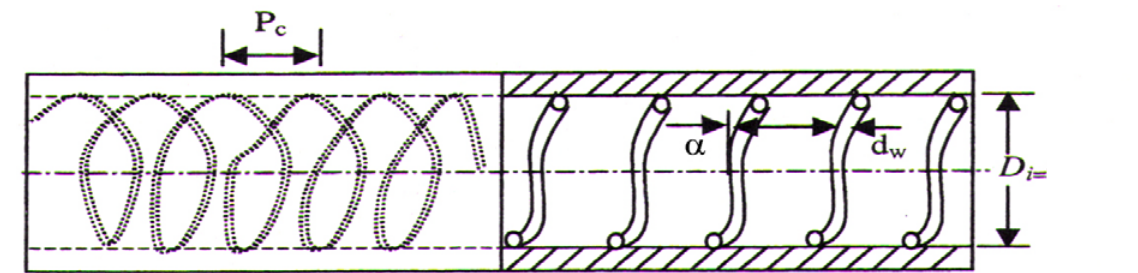
Figure 2: Cross-sectional view of the test